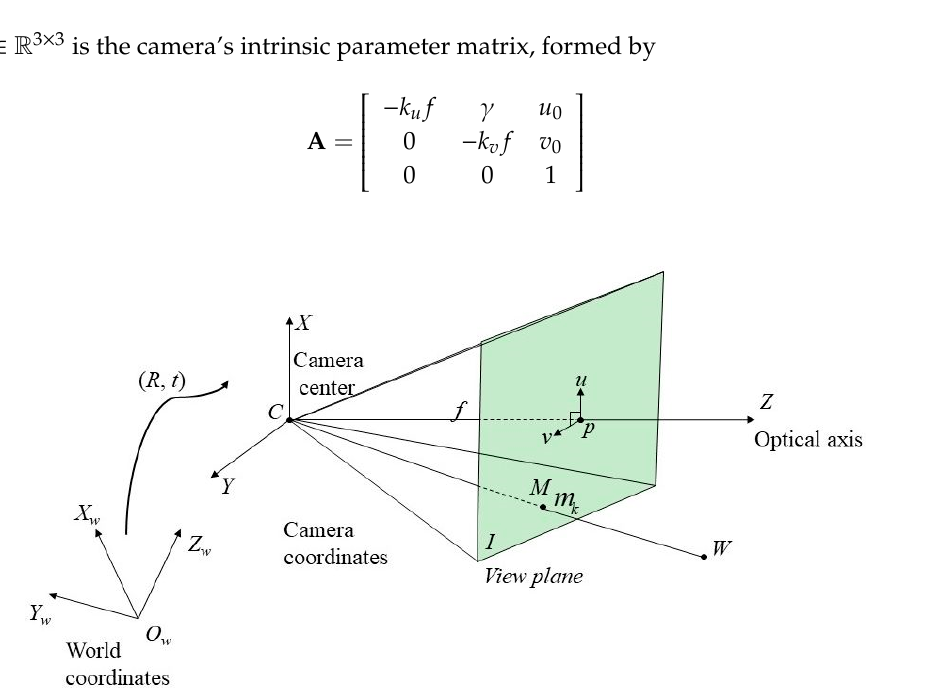
Figure 1. Pinhole camera geometry model. C is the camera center and p is a principal point in the view plane. f is the local length in millimeters.